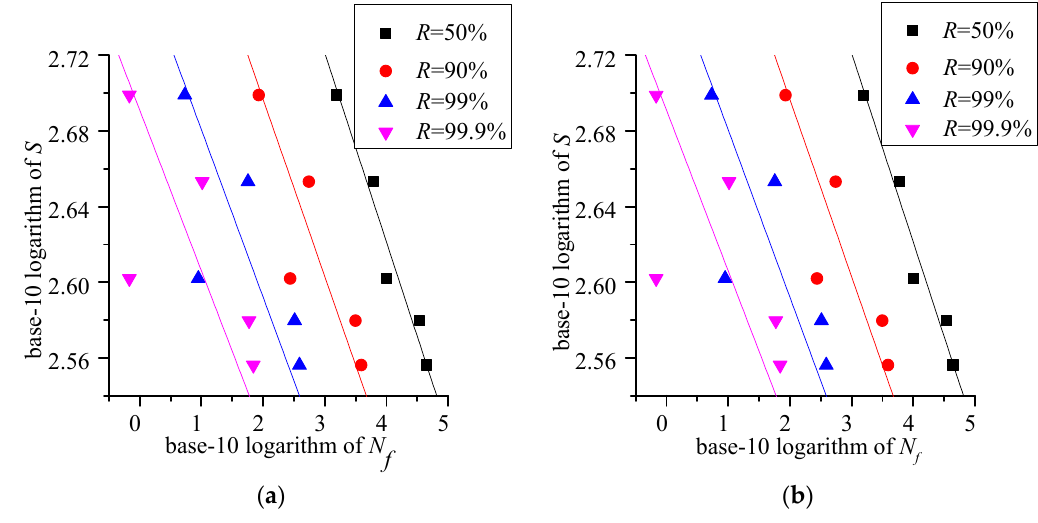
Figure 7. The P-S-N curves with R a = 0.8 μ m and confidence level ( a ) (cid:2011) = 95% ; and ( b ) (cid:2011) = 99% .